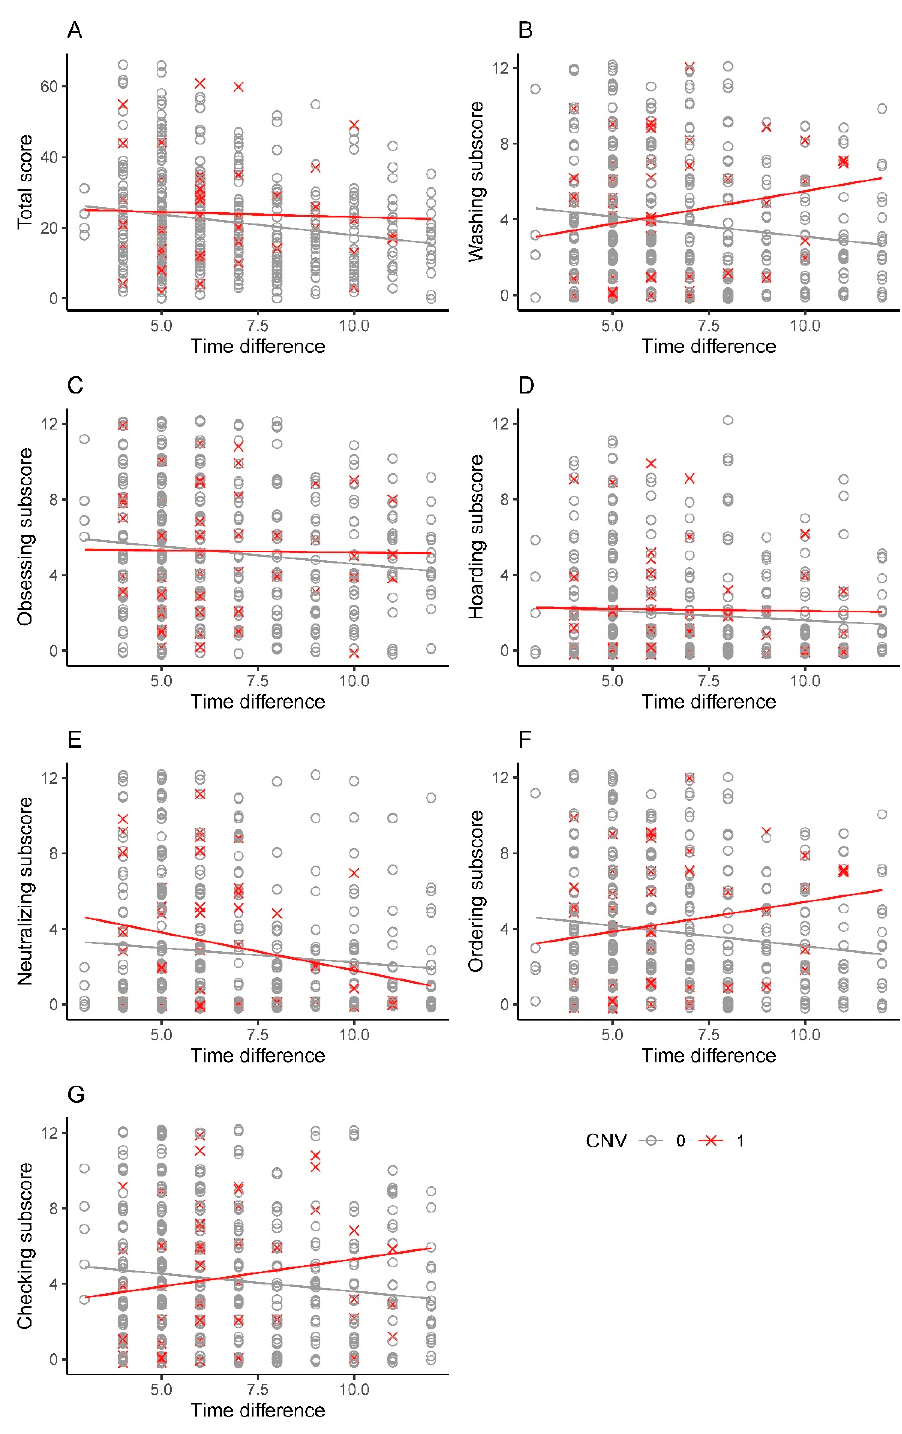
Figure 1. OCI-R score over the difference between an individual’s oldest diagnosis date in the register and the date the individual completed the OCI-R questionnaire, measured in years (time difference). ( A ) OCI-R total score, ( B ) OCI-R Washing subscore, ( C ) OCI-R Obsessing subscore, ( D ) OCI-R Hoarding subscore, ( E ) OCI-R Neutralizing subscore, ( F ) OCI-R Ordering subscore, ( G ) OCI-R Checking subscore. To visualize the overlapping points, we added a small random noise (jitter) to the plots.